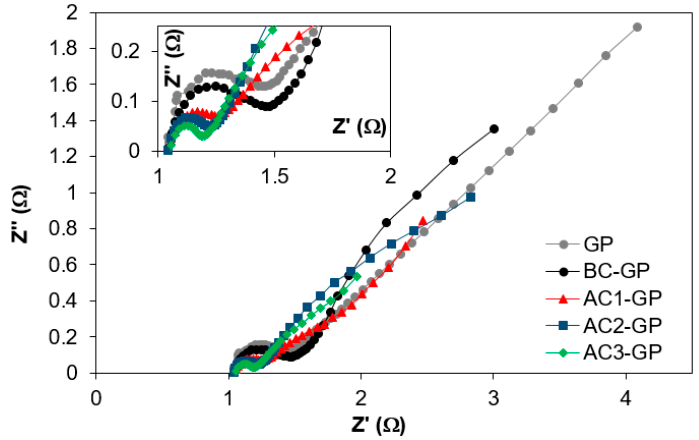
Figure 6. Nyquist plots of EIS measurement of pristine GP (grey curve), GP-modified with biochar (black curve) and carbon activated at different extents, namely AC1 (red curve), AC2 (dark blue curve), and AC3 (green curve) electrodes, in 1.6 M V 4+/5+ containing 4 M H 2 SO 4 . The frequency range used was from 0.1 Hz to 100 kHz at an open circuit potential with an alternating potential amplitude of 10 mV.